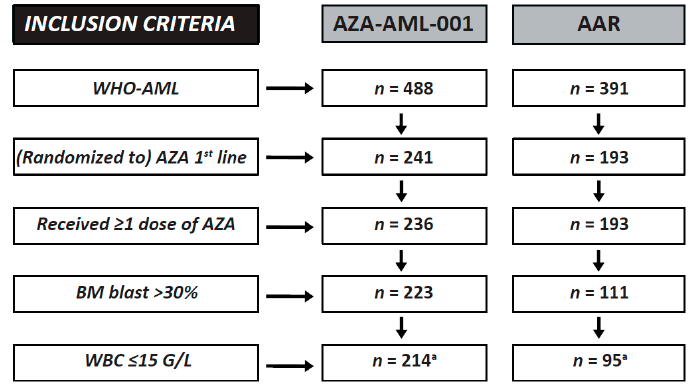
Figure 1. CONSORT diagram. a Subset of patients included in pooled analysis (AML-001-like). Baseline characteristics were similar between the “AML-001” subset and the “AAR (001-like)” subset, including gender, median age, median BM blast count, WBC count, haemoglobin, absolute neutrophil count (ANC), platelets (PLT), prior myelodysplastic syndromes (MDS), transfusion dependence (TD) and National Comprehensive Cancer Network (NCCN) cytogenetic risk (Table 1). The only notable differences were the presence of patients with ECOG-PS 3–4 (9.5%; nine patients) and the presence of patients with good-risk cytogenetics (2.1%; two patients) within the “AAR (001-like)” subset, both of which were exclusion criteria in the “AML-001” subset (Table 1). Table 1. Baseline characteristics of acute myeloid leukaemia (AML) patients treated with azacitidine front-line per patient subset.